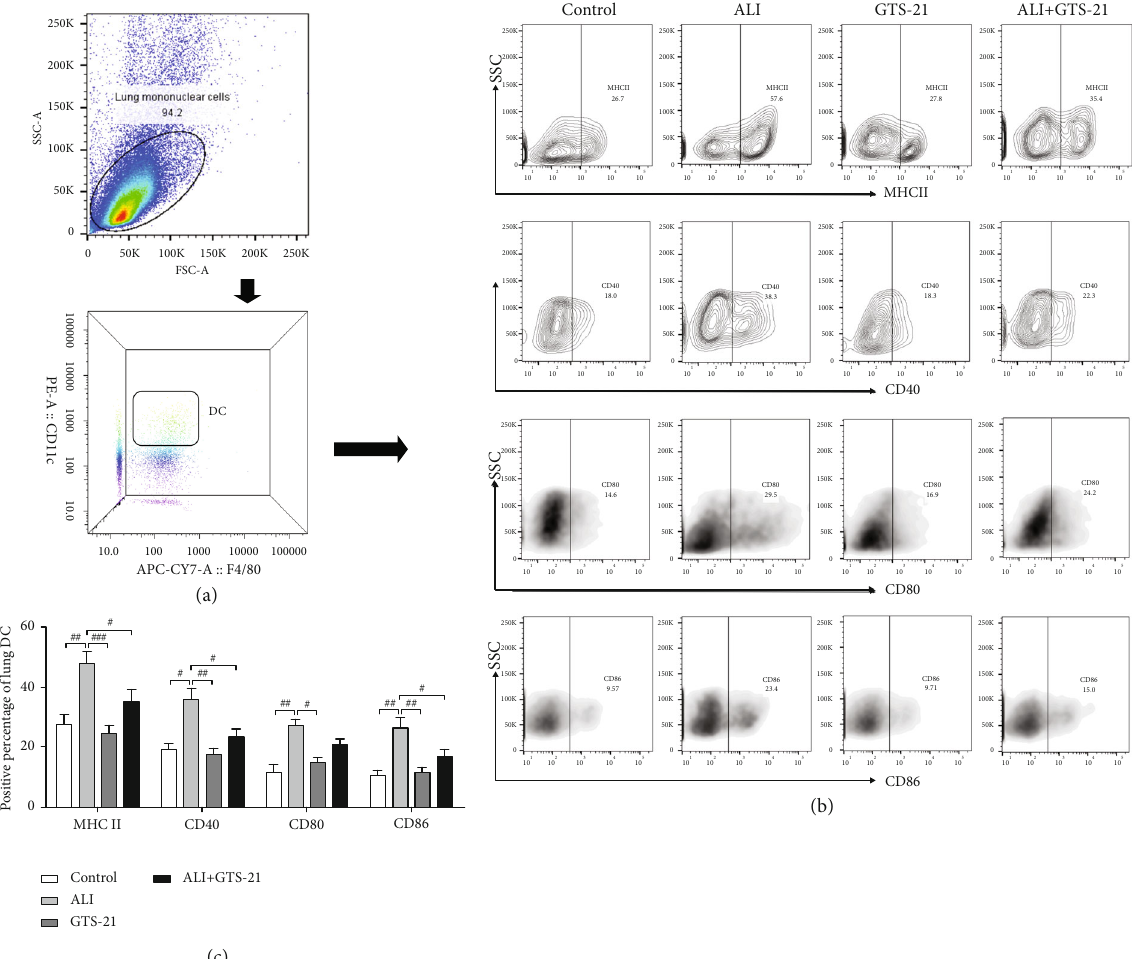
Figure 1: GTS-21 administration inhibited the maturation of DCs in the lungs of ALI induced by sepsis. (a) Flow cytometry analysis was used to examine the CD11c + F4/80 - lung DCs isolated from lung MNCs of mice. (b, c) Detecting the percentages of MHCII-, CD40-, CD80-, and CD86-positive expression on the surface of lung DCs. n = 4 – 6 mice/group. All data are shown as mean ± SD . # p < 0 : 05 , ## p < 0 : 01 , ### p < 0 : 001